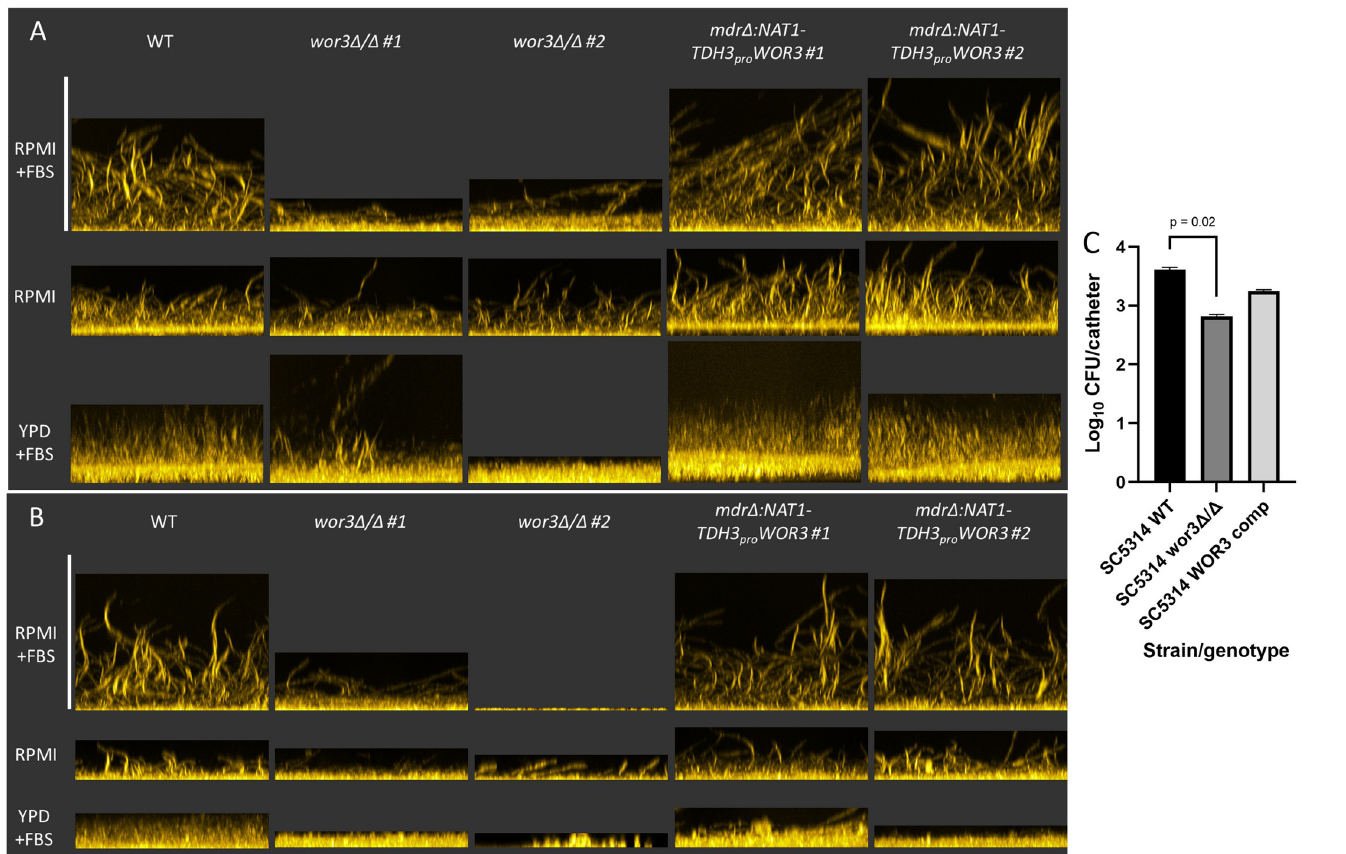
Fig 8. Biofilm formation dependence on WOR3 . Panels A and B. Biofilm formation ability for WT, wor3 Δ / Δ , and complemented strains was assessed at 37˚C for 24 hrs in RPMI, RPMI+10% FBS, and YPD+10% FBS in both SC5314 (Panel A) and P87 (Panel B) backgrounds using the “96 well plate–Fluorescence microscopy” method. Side-view images of two independent mutant strains were tested for each clinical isolate background for both the wor3 Δ / Δ and complemented strains. Scale bars are equal to 285 μ m. Panel C. SC5314-derived wild-type, mutant, and complemented strains were tested for biofilm formation in a rat venous catheter infection model [21]. C . albicans cell counts per catheter were determined at 48 hr post-infection. Wild-type and mutant strains differed with p-value = 0.02.